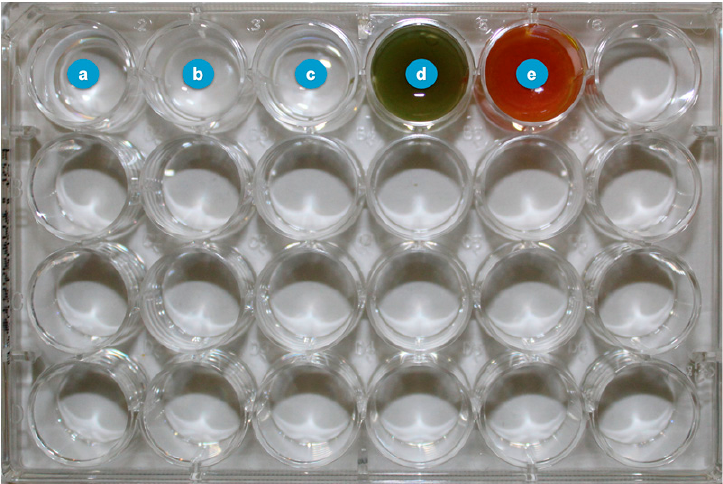
Figure 8. Microplate wells with the decontamination groups ( a ) phosphate-buffered saline (PBS), ( b ) chlorhexidine (CHX), ( c ) dimethyl sulfoxide (DMSO), ( d ) xanthohumol and ( e ) curcumin.